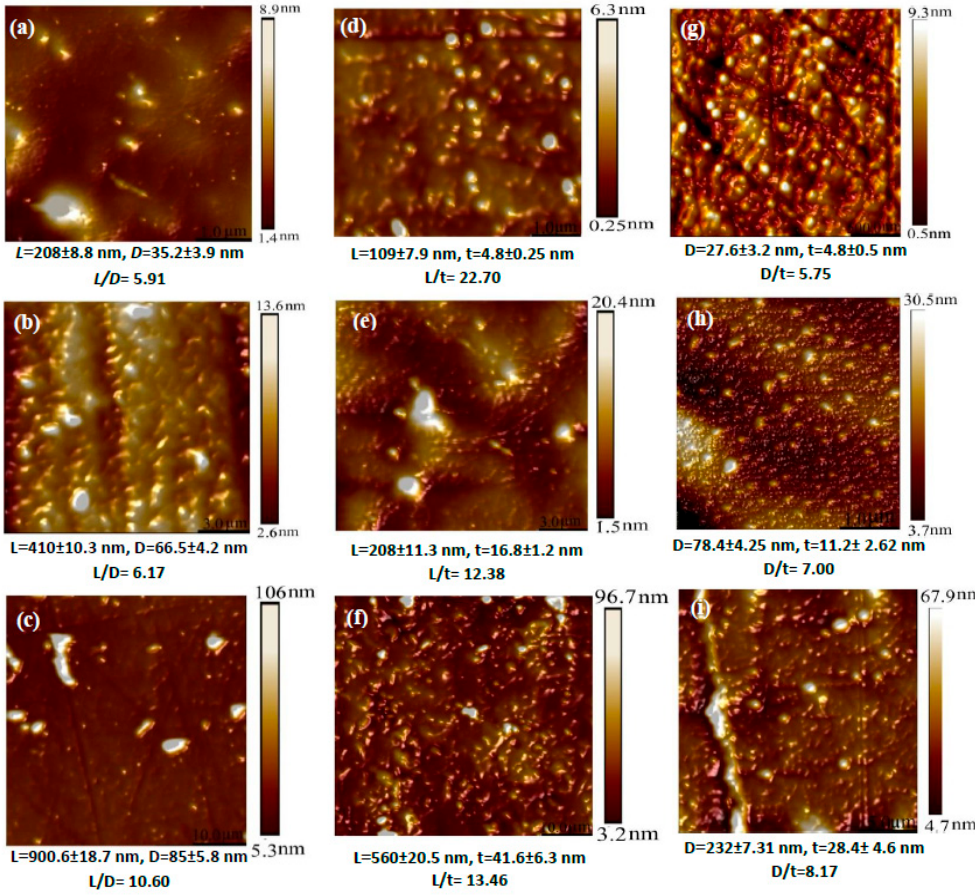
Figure 6. AFM topographic images of PVA bionanocomposites associated with aspect ratios of embedded fillers: ( a ) 3 wt % HNTs, ( b ), 5 wt % HNTs, ( c ) 10 wt % HNTs, ( d ) 3 wt % Cloisite 30B clays ( e ) 5 wt % Cloisite 30B clays, ( f ) 10 wt % Cloisite 30B clays, ( g ) 3 wt % NBCs ( h ) 5 wt % NBCs, and ( i )